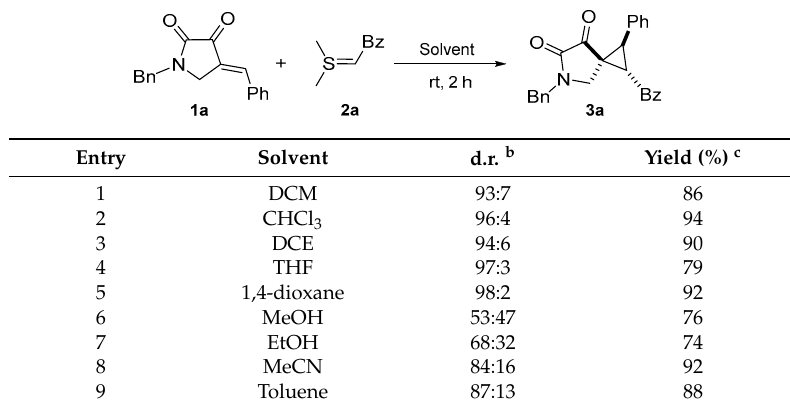
Table 1. Screening studies of the cyclopropanation reaction a .